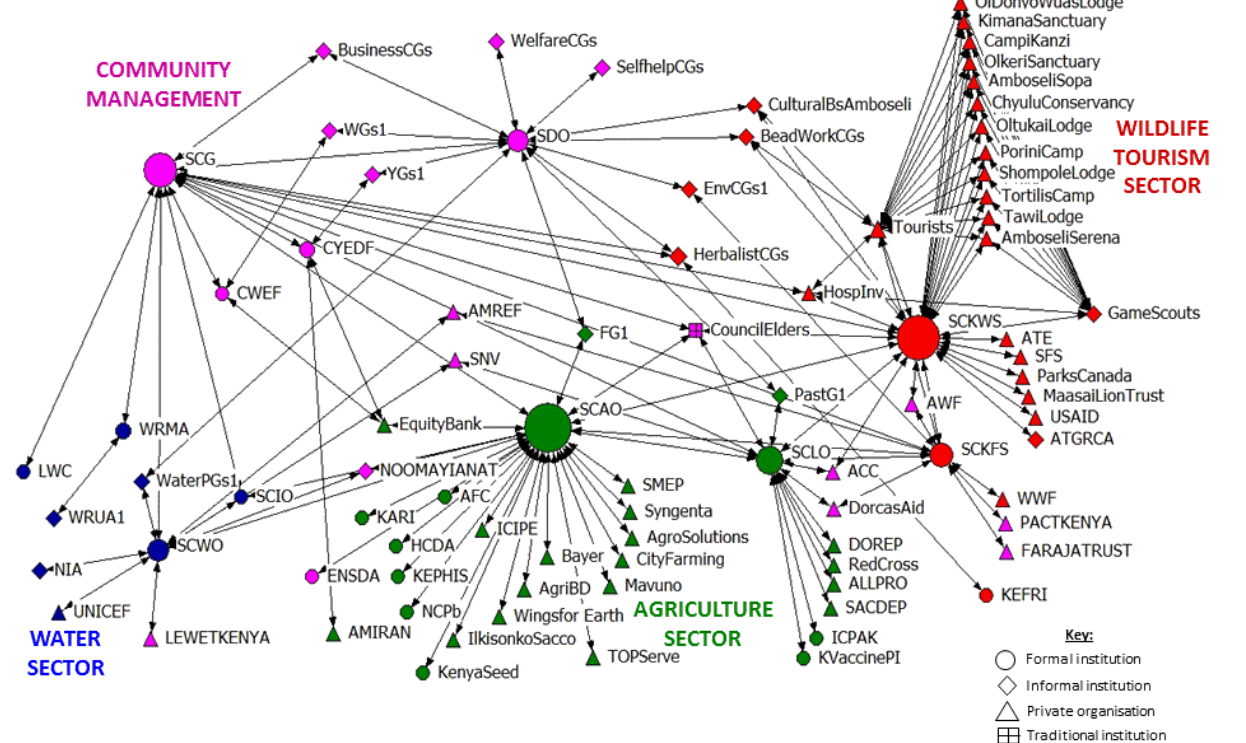
Figure 3. Social network illustrating actor linkages in resource governance at Loitoktok